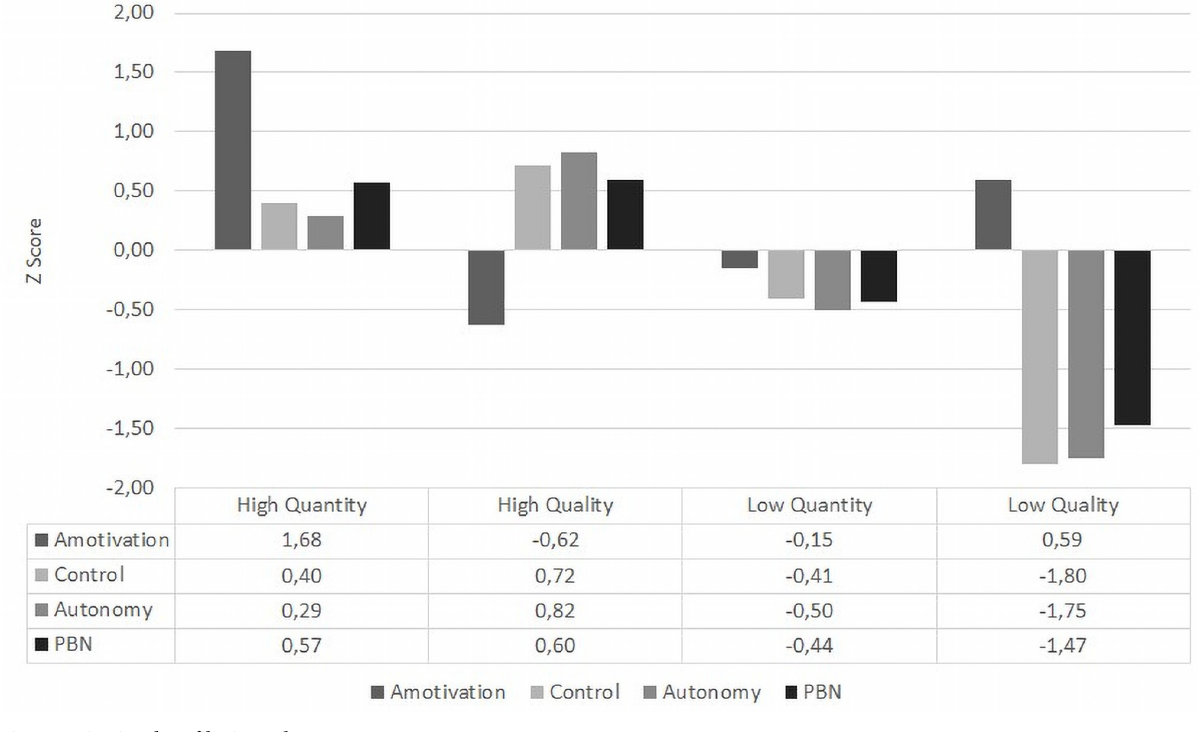
Fig 1. Motivational profiles in students.